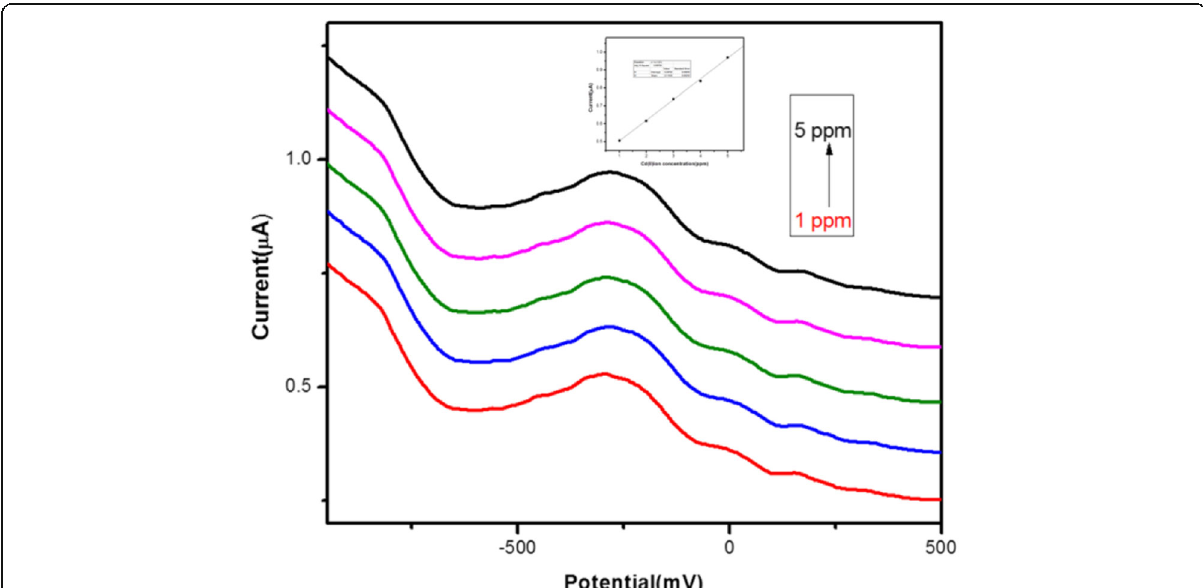
Fig. 12 Differential pulse voltammograms at modified platinum electrode with different concentration of Cd(II) ion and inset plot the calibration curve